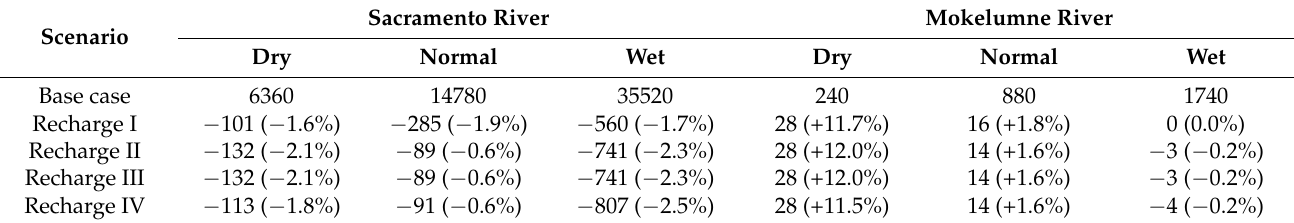
Table 8. Annual average change, hm 3 /yr (change in % with respect to base case), in surface water return flow towards Delta in the confluence of Sacramento and Mokelumne River for different water year